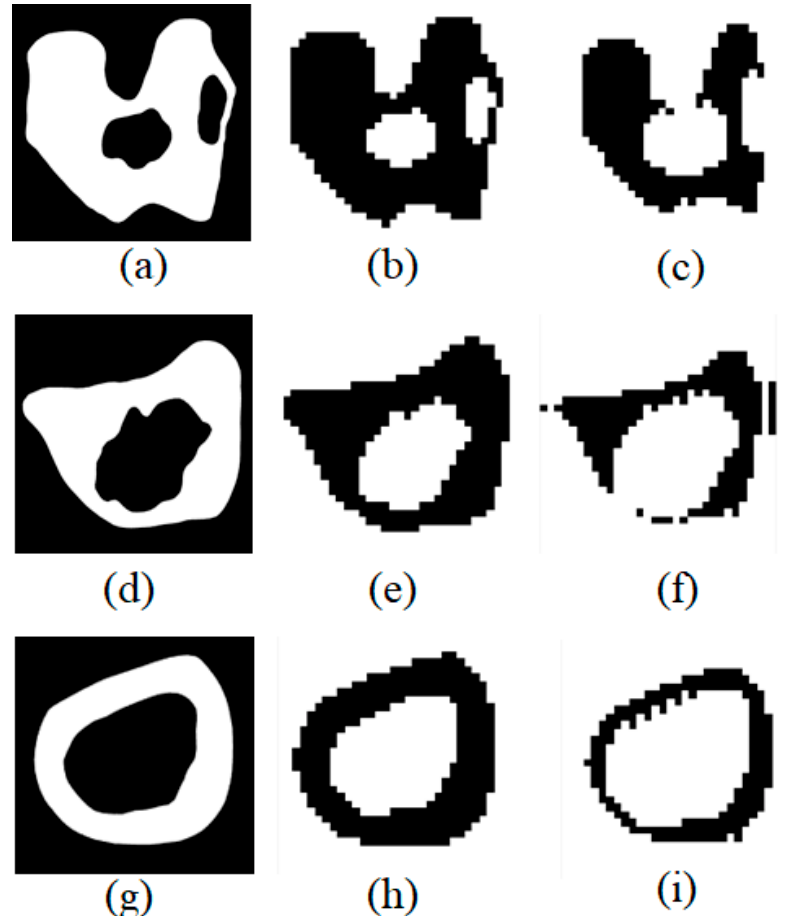
Figure 7. Depth convolution is used to extract multi-scale features of each layer with incremental h n 0.23, 0.42, and 0.73, where ( a , d , g ) are original LCM with 32 × 32 resolution ratio; ( b , e , h ) are, respectively, LCMs with 32 × 32 resolution ratio; ( c , f , i ) are multi-scale convolution feature with dimension of 5 × 5 convolution kernel W